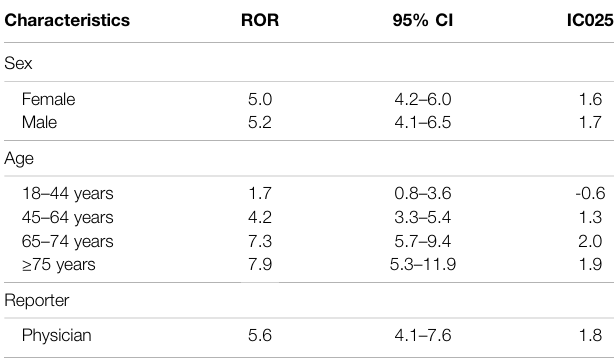
TABLE 3 | Subgroup disproportionality analyses for COVID-19 vaccine reports of TGA.